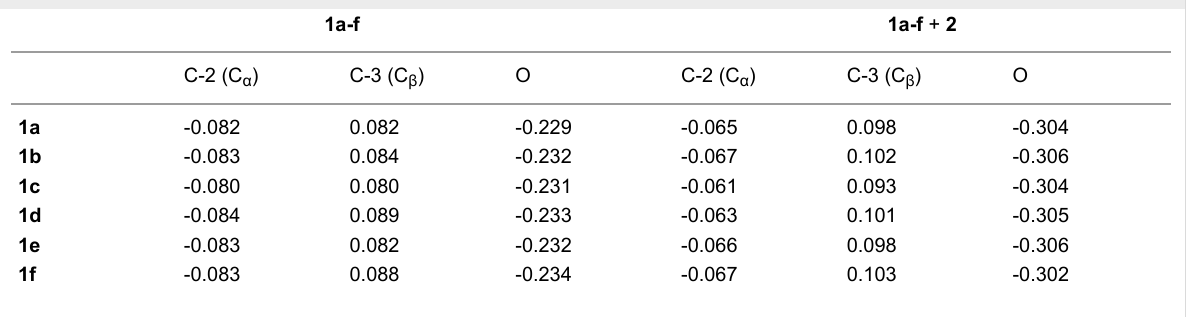
Table 3: Mulliken electric charges [52,53] of the epoxide ring atoms of 1a-f alone and the complexes of α-epoxyketones 1a-f with 2 in the ground state obtained from quantum mechanical PM3 calculations